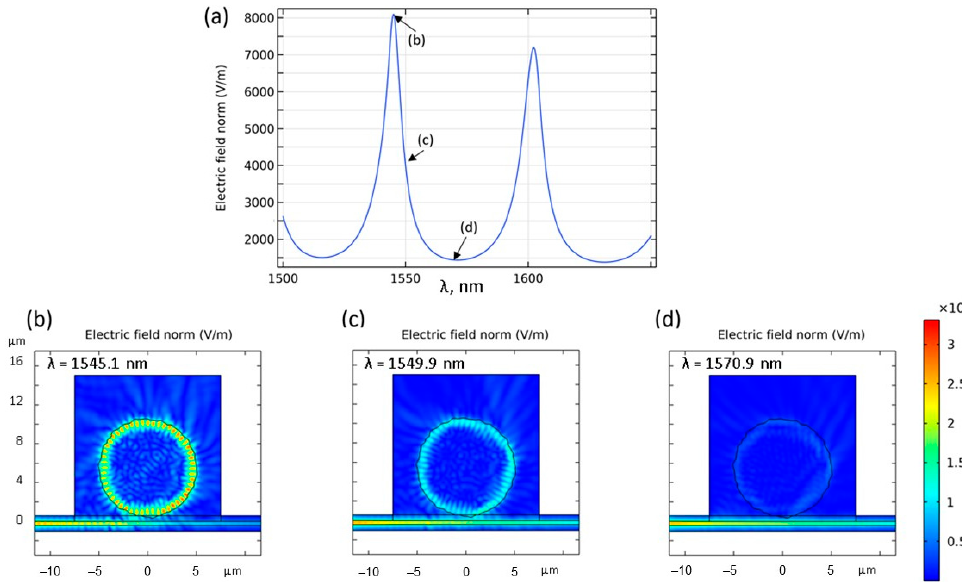
Figure 7. 2D COMSOL simulations to examine light scattering from spherical microresonators with 10 µm diameter. In this case, the surface of the microresonator was not perfectly round, the outer layer was deformed. ( a ) The absorption spectrum of the PMMA microsphere, letters ( b – d ) in the graph indicate the wavelengths chosen for further analysis. 2D image for electric field distribution of the PMMA microsphere with a deformed surface at ( b ) 1545.1 nm matching the resonance, ( c ) 1549.9 nm detuned from the resonance, and ( d ) 1570.9 nm off the resonance.